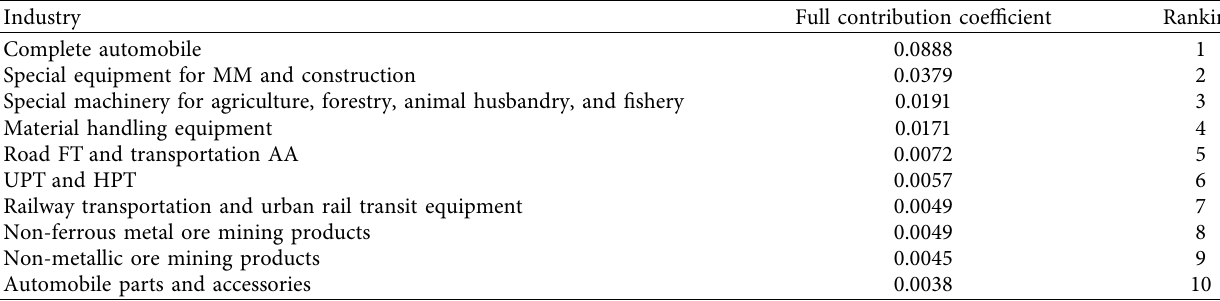
Table 6: Top 10 industries for full contribution coefficient.